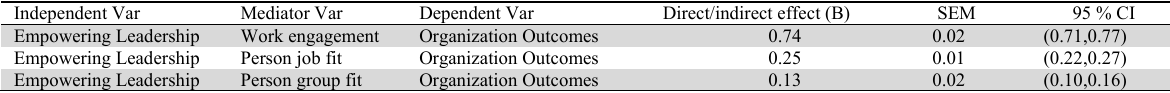
Bootstrap analysis of the magnitude and statistical significance of the direct and indirect effects.